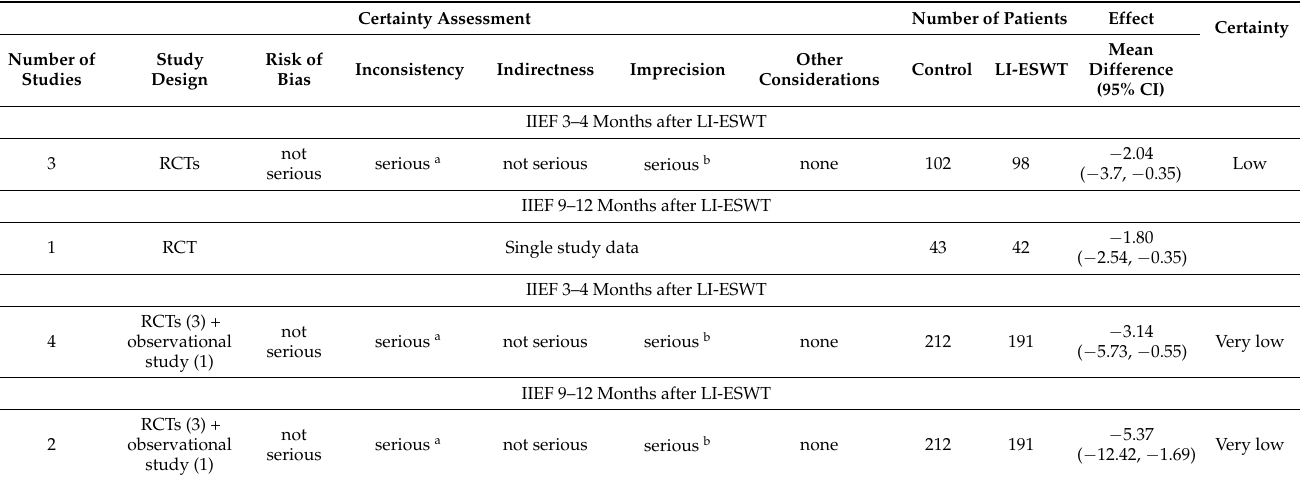
Table 3. Results of the GRADE quality